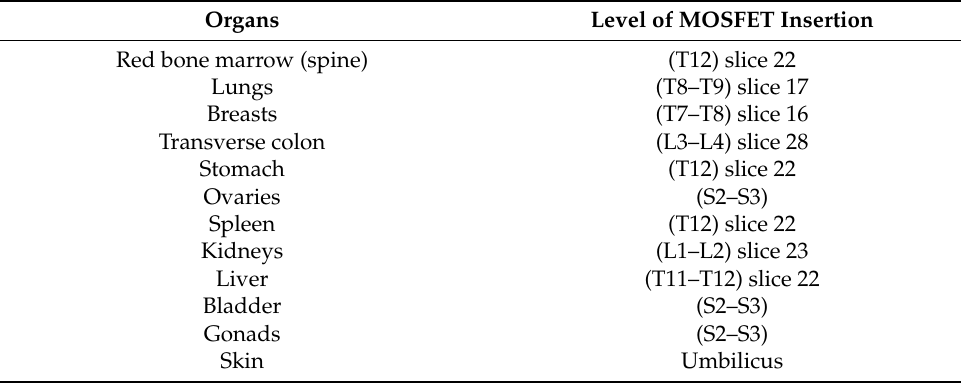
Table 2. The organs and their locations used for MOSFET